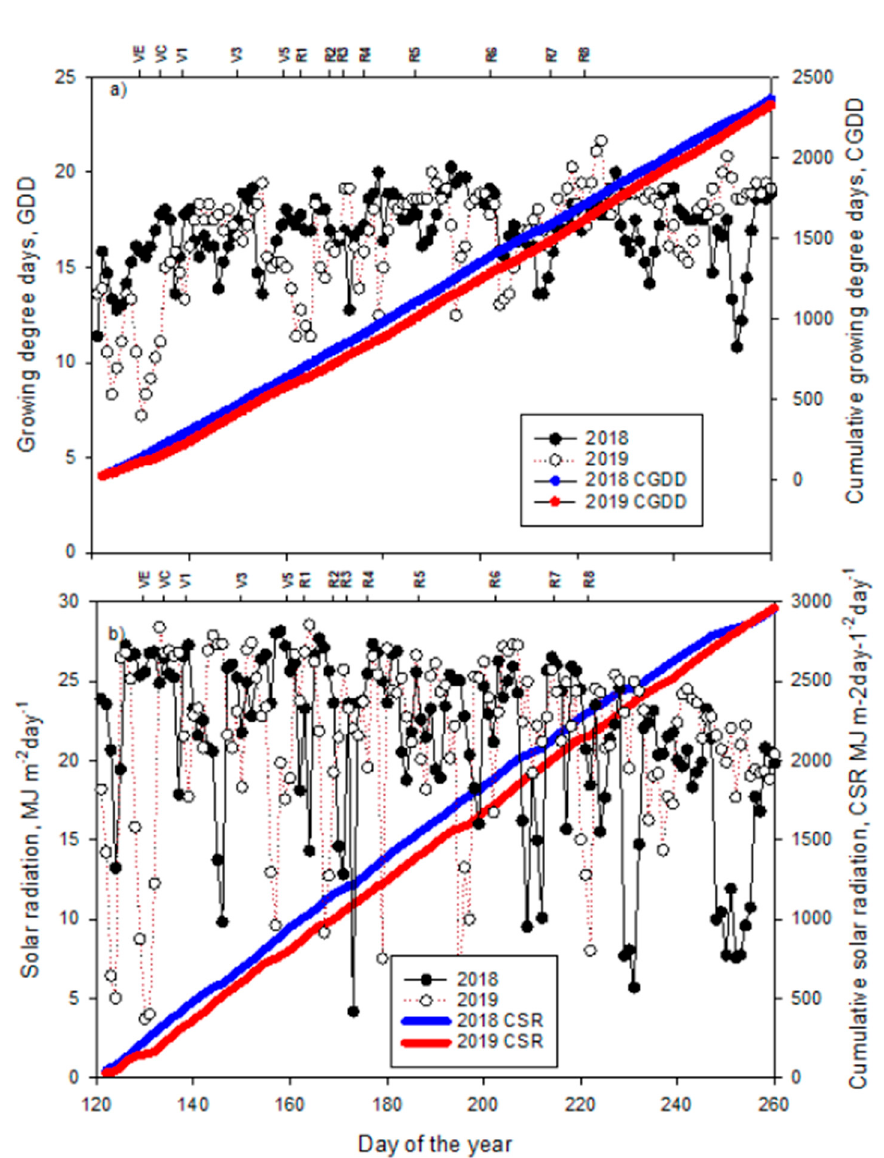
Figure 2. Measured ( a ) growing degree days (GDD, °C) computed using 10 °C as base temperature, cumulative growing degree days (CGDD) and ( b ) monthly averaged daily solar radiation, cumulative solar radiation (CSR) in 2018 and 2019 soybean growing seasons at Stoneville, MS, USA. Table 1. Significance of the main effects of irrigation regimes, crop season, and planting pattern (PP) and their interactions on biomass quality traits at Stoneville, MS during the 2018–2019 crop seasons. Source of